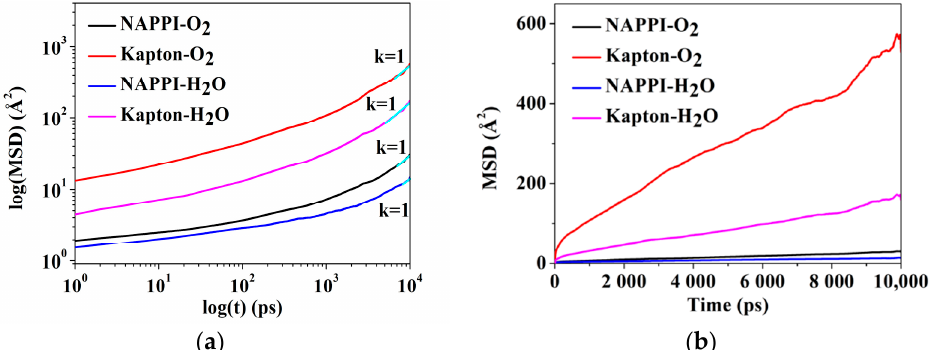
Figure 14. ( a ) log(MSD) and ( b ) mean square displacement (MSD) diagrams of H 2 O and O 2 in polyimide as a function of time.